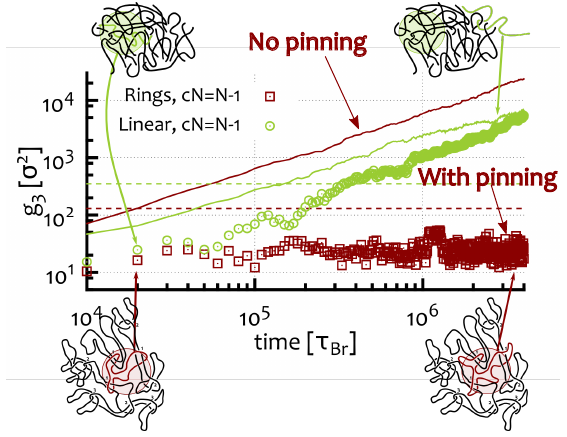
Figure 7. Comparison between the mean square displacements of the centre of mass of the mobile polymers in four cases. Open green circles: A mobile linear chain in a background of pinned (frozen) linear chains. Open red squares: A mobile ring polymer in a background of pinned (frozen) ring polymers. Green curve is for a melt of linear polymers while red line for a melt of ring polymers . Insets sketch melts of linear (top row) and ring (bottom row) polymers. All systems have the same monomer density ρ = 0.1 σ − 3 , and include N = 50 polymers, each of length M = 256